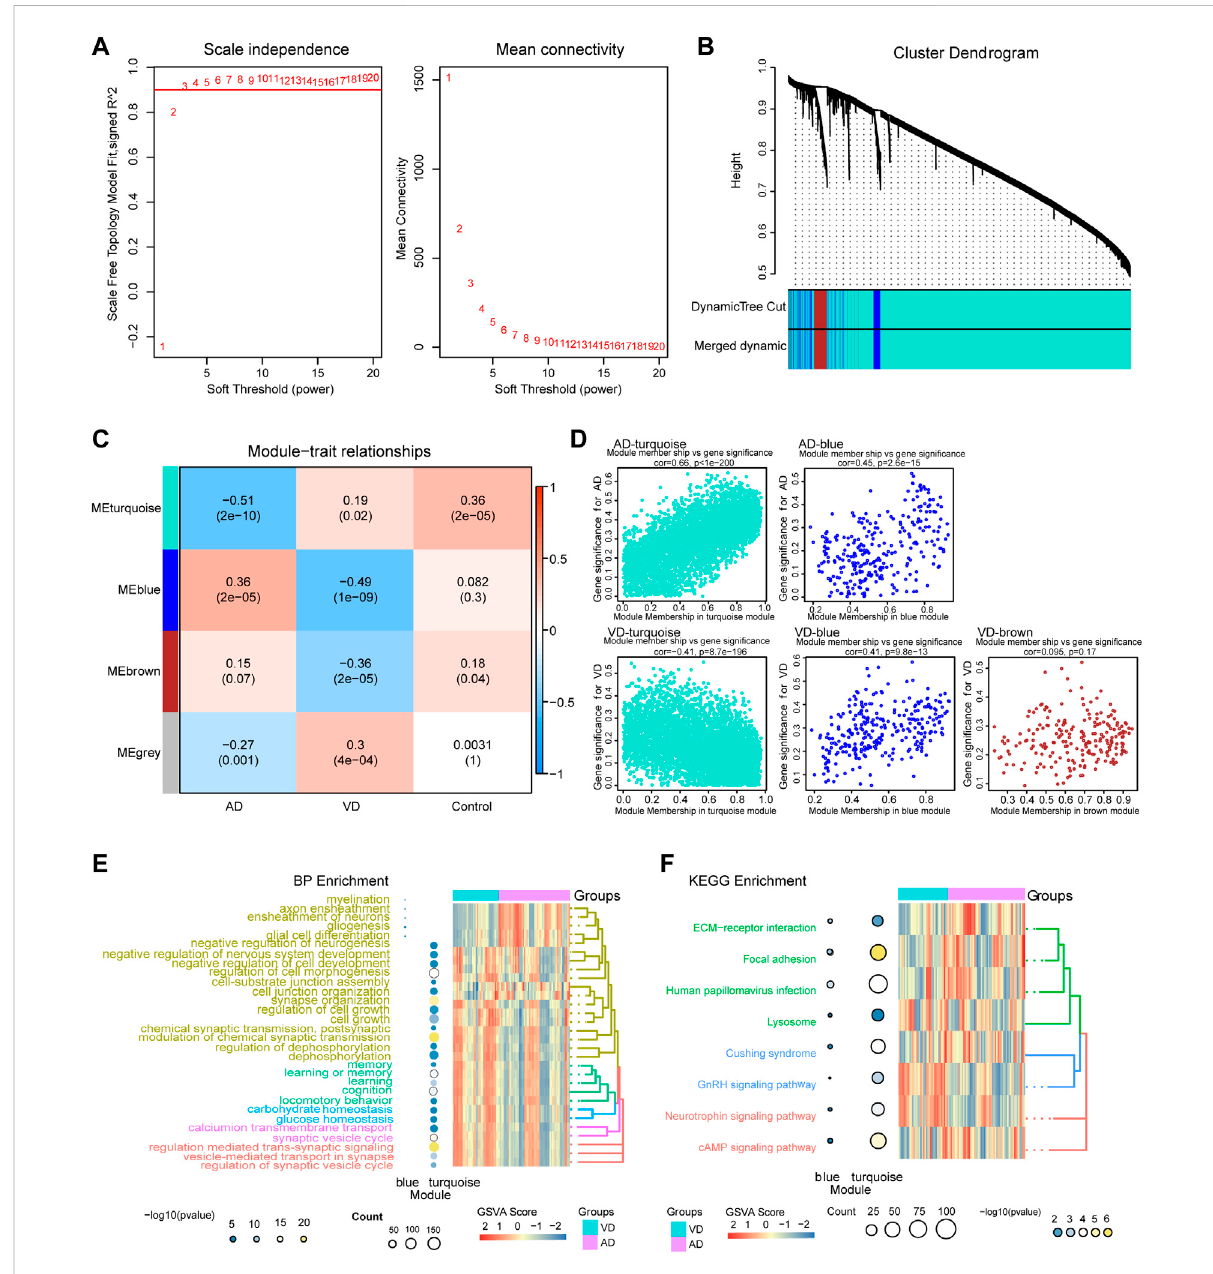
FIGURE 3 Weighted Gene Co-Expression Network Analysis. (A) De fi nition of power related to modules. (B) Recognition module. (C) The turquoise module negatively correlated with AD and positively correlated with VD, blue module was positively correlated with AD, but the opposite of VD, brown module was negatively correlated with VD. Red, positive correlstion; Blue, negative correlation. (D) Module membership and gene signi fi cancestronglycorrelatedwitheachotherwithineachmodule. (E) Biologicalprocessesinvolvinggenesofthedifferentmodules. (F) KEGG pathways involving genes of the different modules. AD, Alzheimer ’ s disease; VD, vascular dementia; KEGG, Kyoto Encyclopedia of Genes and